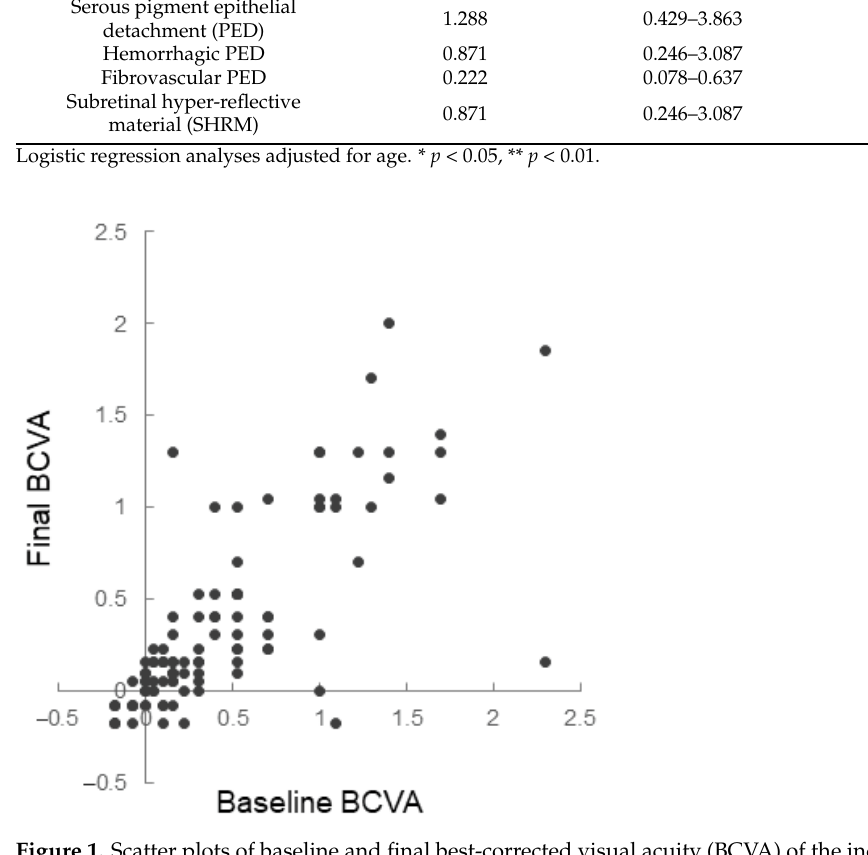
Table 2. Predictive factors for maintained or improved best-corrected visual acuity at the last visit, after adjusting for age.